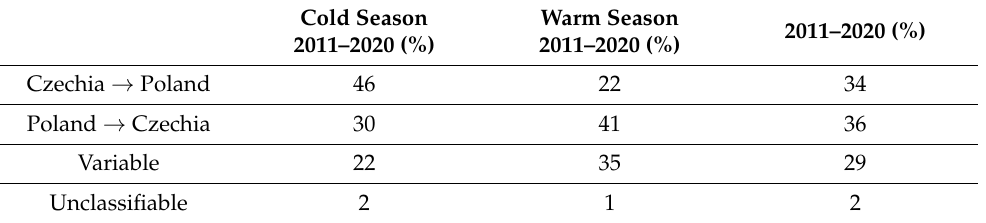
Table 1. Quantification of wind directions between the Czech Republic and Poland, 2011–2020.